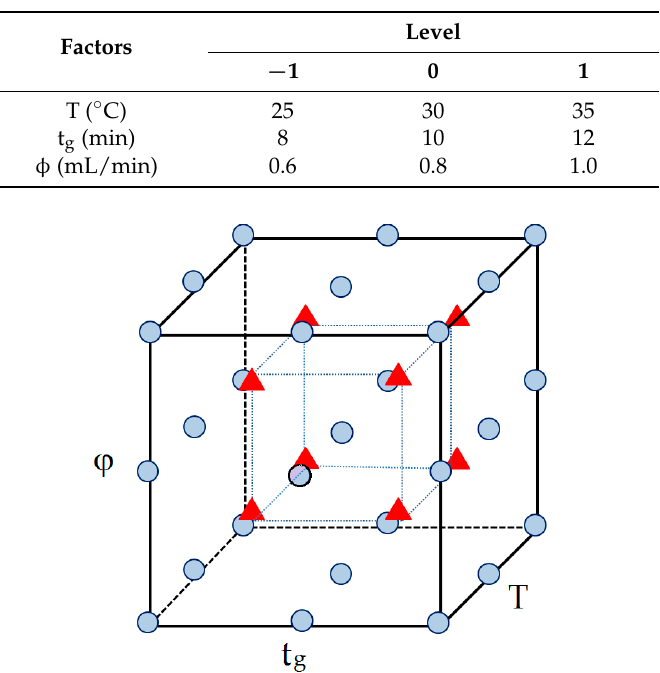
Table 4. Factors and levels of the full-factorial design of experiments (DOE).